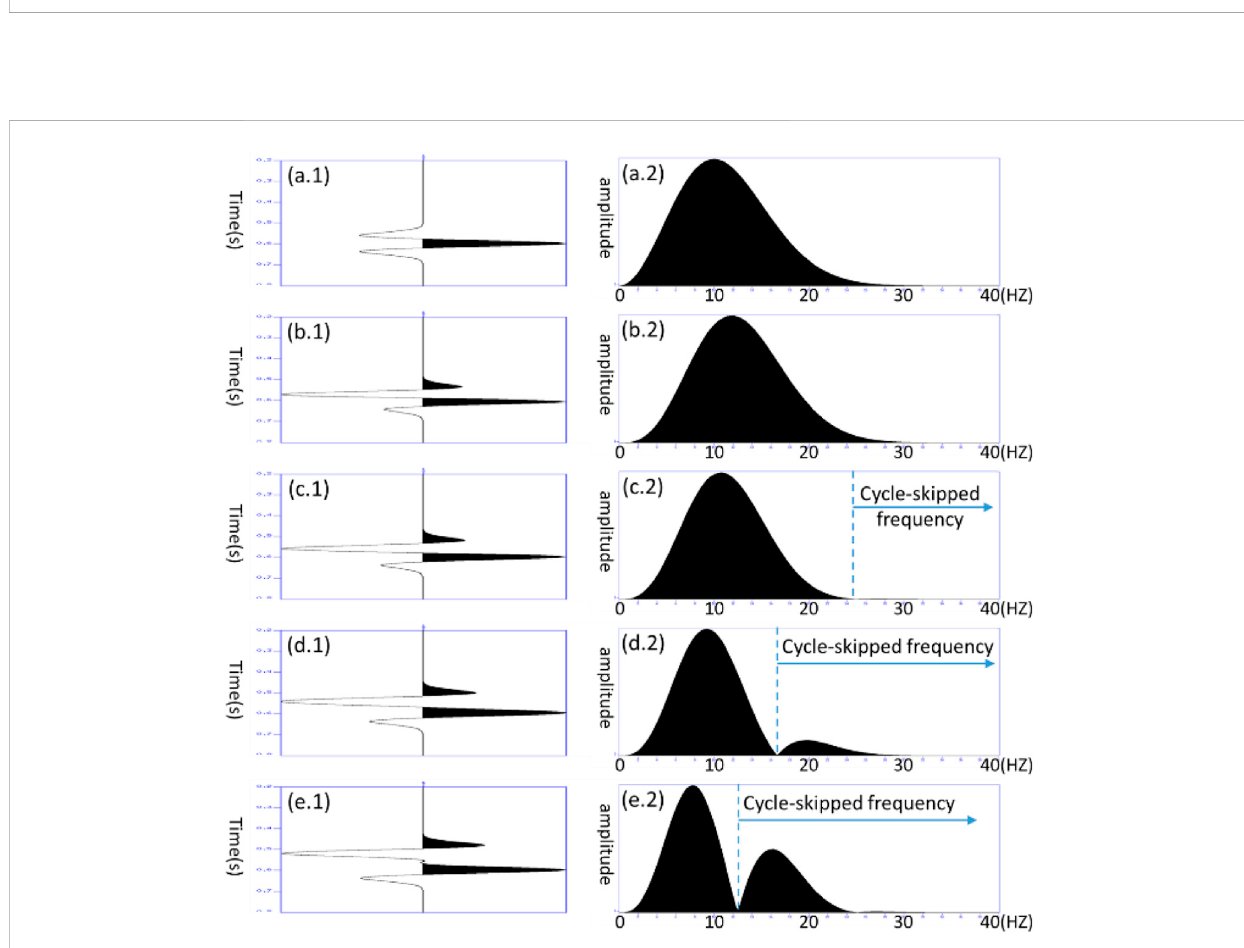
FIGURE 2 Detailed adjoint source and thecorresponding frequency distribution at different arrival times. (a.1 – a.2) Ricker wavelet as a reference source and its frequency distribution. (b.1 – e.2) Adjoint source and the corresponding frequency distribution when the arrival time changes from 20 ms to 80 ms.